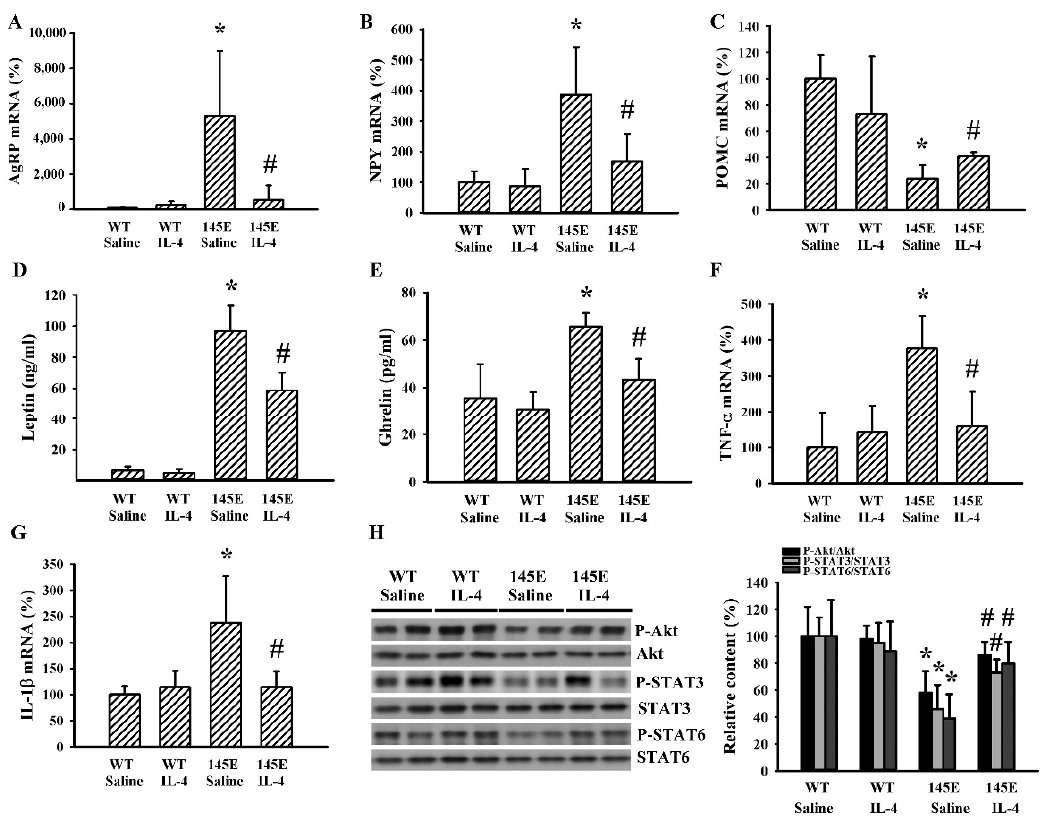
Figure 3. IL-4 ameliorated hypothalamic changes in leptin-deficient mice. Wild-type C57BL / 6 (WT) and leptin-deficient 145E mice were fed the normal diet (ND) for 8 weeks. Simultaneously, normal saline and IL-4 (1 µ g / mouse) were intraperitoneally administrated twice a week. Total RNAs were extracted from the hypothalamic tissues and subjected to qRT-PCR for the measurement of AgRP ( A ), NPY ( B ), POMC ( C ), TNF- α ( F ), and IL-1 β ( G ) mRNA expression. Blood samples were collected and subjected to ELISA for the measurement of leptin ( D ) and ghrelin ( E ) levels. Proteins were extracted from the hypothalamic tissues and subjected to Western blot analysis with the indicated antibodies. Representative blots and quantitative data are shown ( H ). * p < 0.05 vs. WT/saline group and # p < 0.05 vs. 145E/saline group, n = 6.